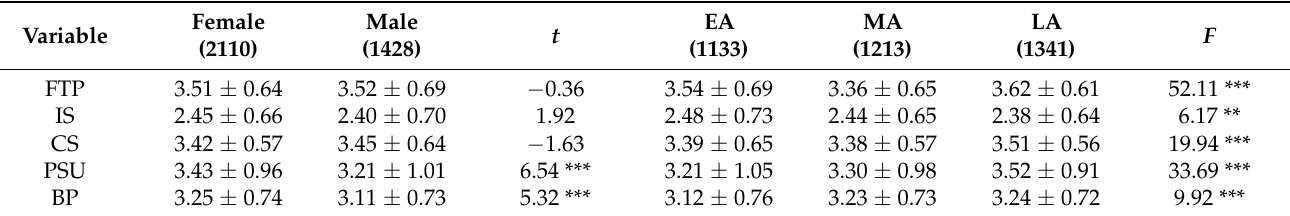
Table 2. Gender and age group difference among